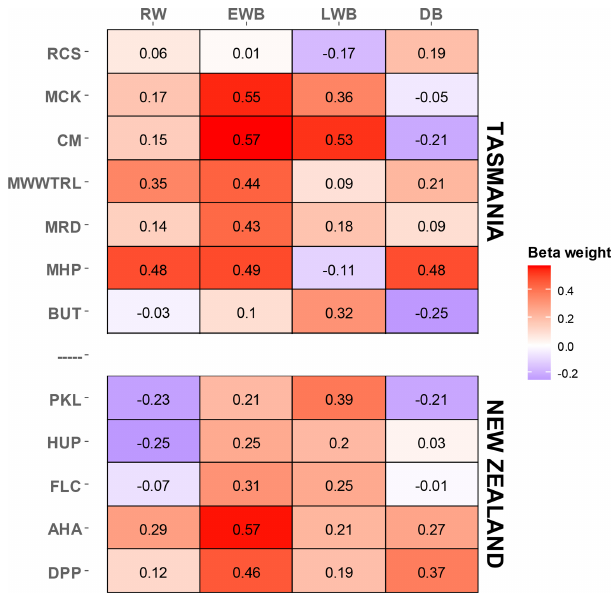
Table 3. PC regression calibration (1901–1995) beta weights using all parameter and species data. The Tasmanian modelling was per- formed against January–February temperatures while New Zealand was with